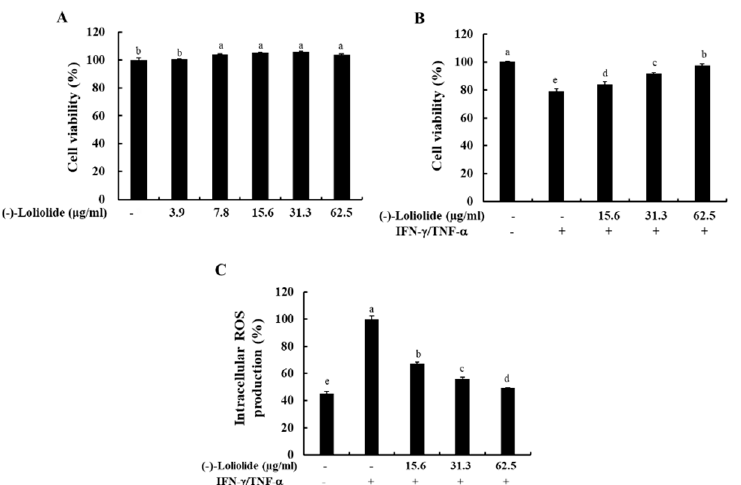
Figure 1. Effects of (–)-loliolide on cell viability ( A , B ) and intracellular ROS production ( C ) in IFN- γ /TNF- α -stimulated HaCaT keratinocytes. The results represent data from three independent experiments (n = 3), and the values are indicated as the mean ± SE. Error bars with different letters are significantly different ( p < 0.05).